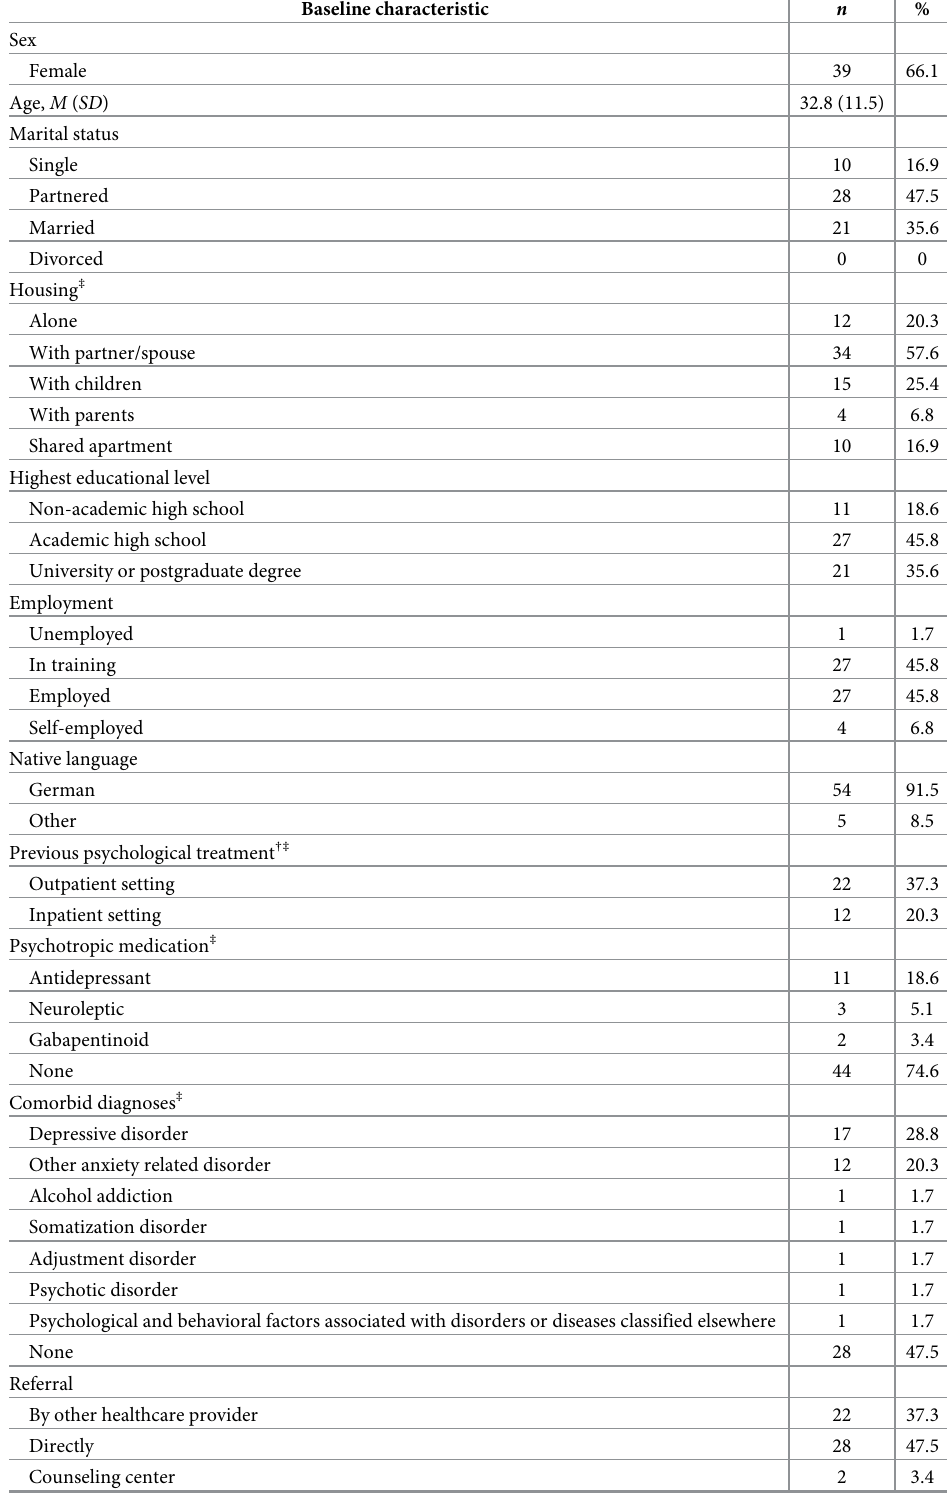
Table 1. Characteristics of patients at